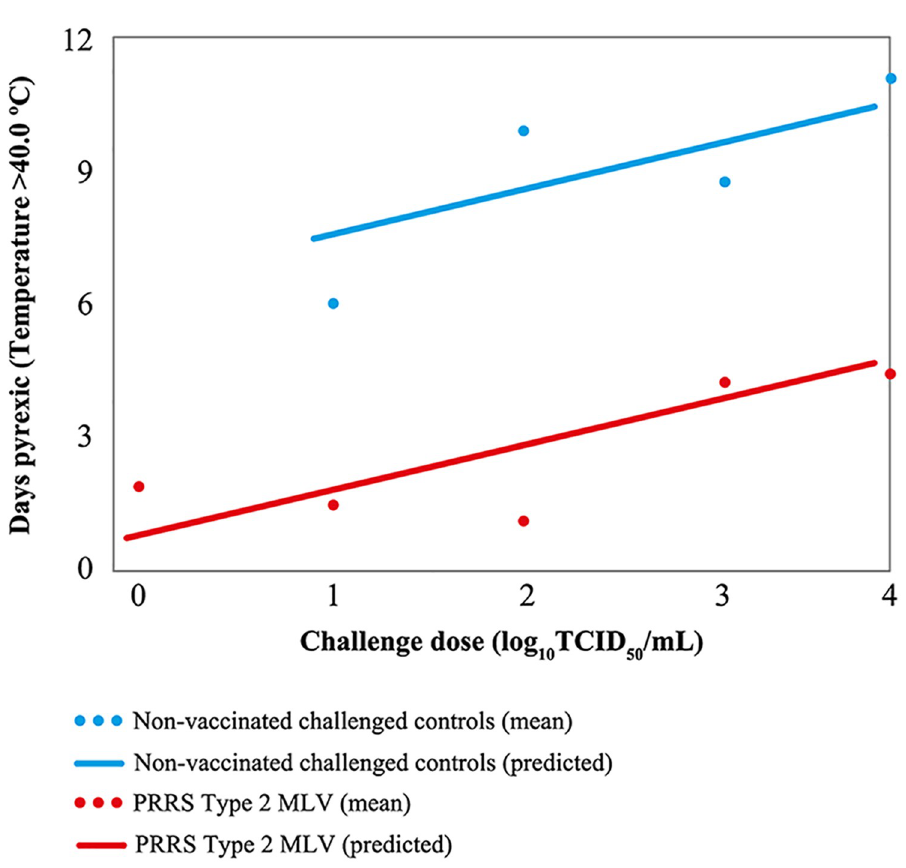
Fig 2. Estimated number of days pyrexic by challenge dose based on model prediction. Regression intercept and slope utilised to predict number of days pyrexic. Individual data points show mean average number of days pyrexic for each challenge dose group as recorded between Days 28 and 70. MLV = modified-live virus; PRRS = porcine reproductive and respiratory syndrome; TCID 50 = 50% tissue culture infectious dose.